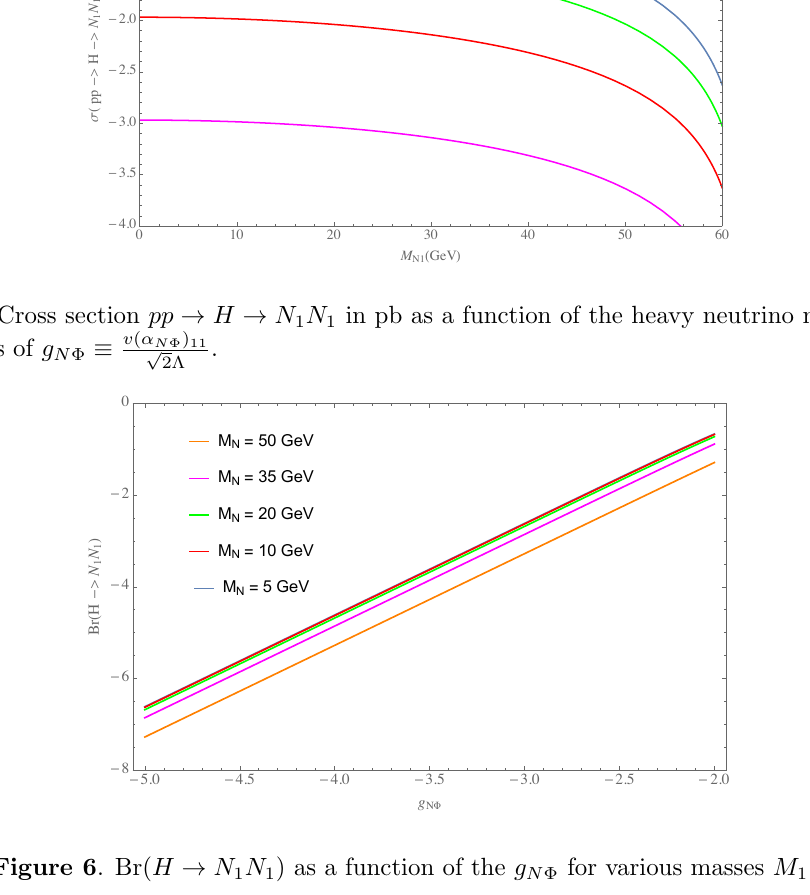
Figure 6 . Br( H N 1 N 1 ) as a function of the g N (cid:8) for various masses M 1 . !